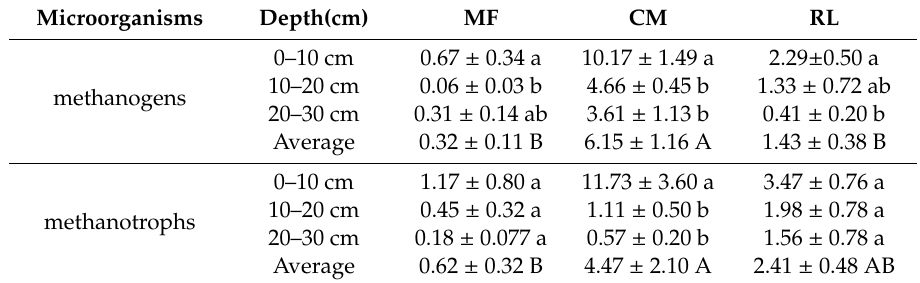
Table 1. The vertical pattern of the abundance of methanogens (gene copies g − 1 dws × 10 7 ) and methanotrophs (gene copies g − 1 dws × 10 5 ) in three sites of the Dongting Lake